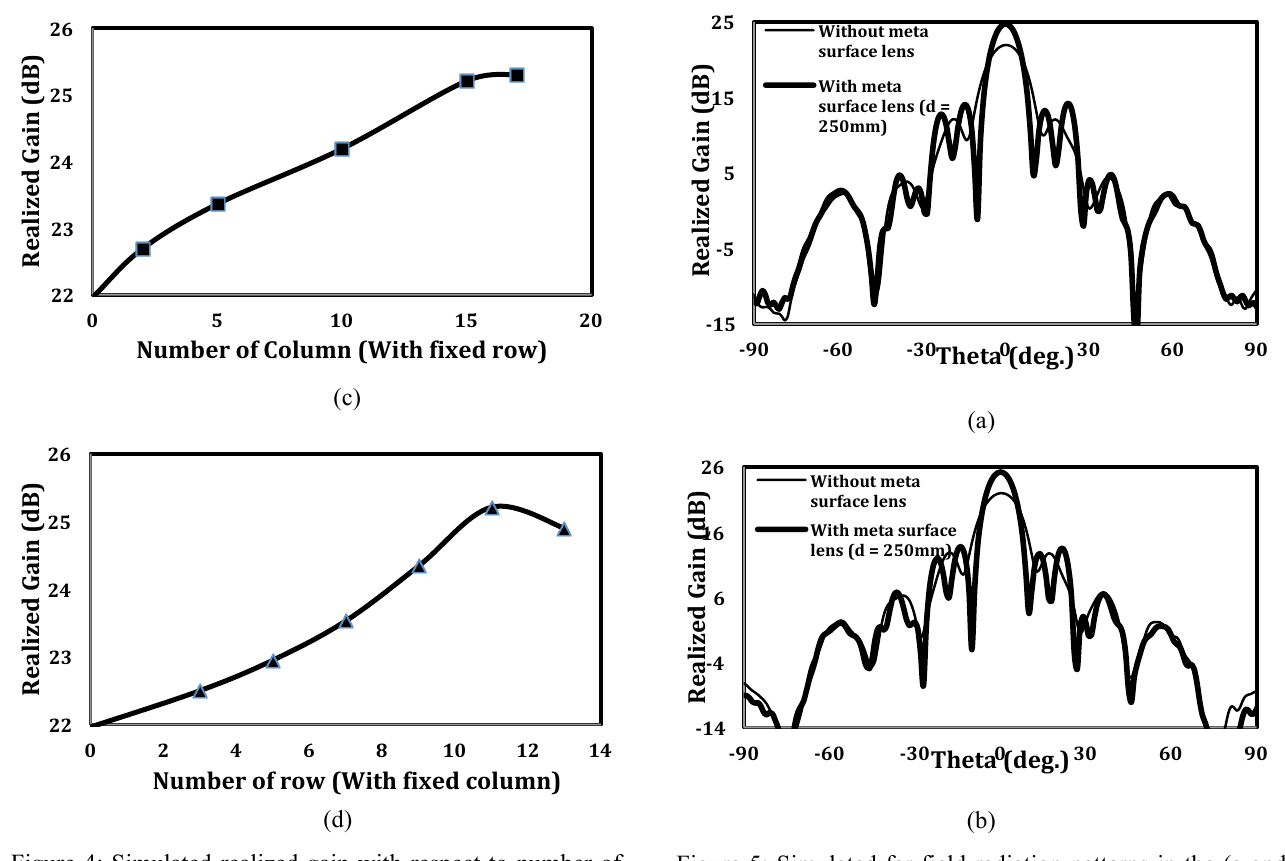
Figure 5: Simulated far-field radiation patterns in the (a and b) at E –plane of the horn antenna loaded outside with and without meta surface at 9.7GHz and 10GHz, respectively.